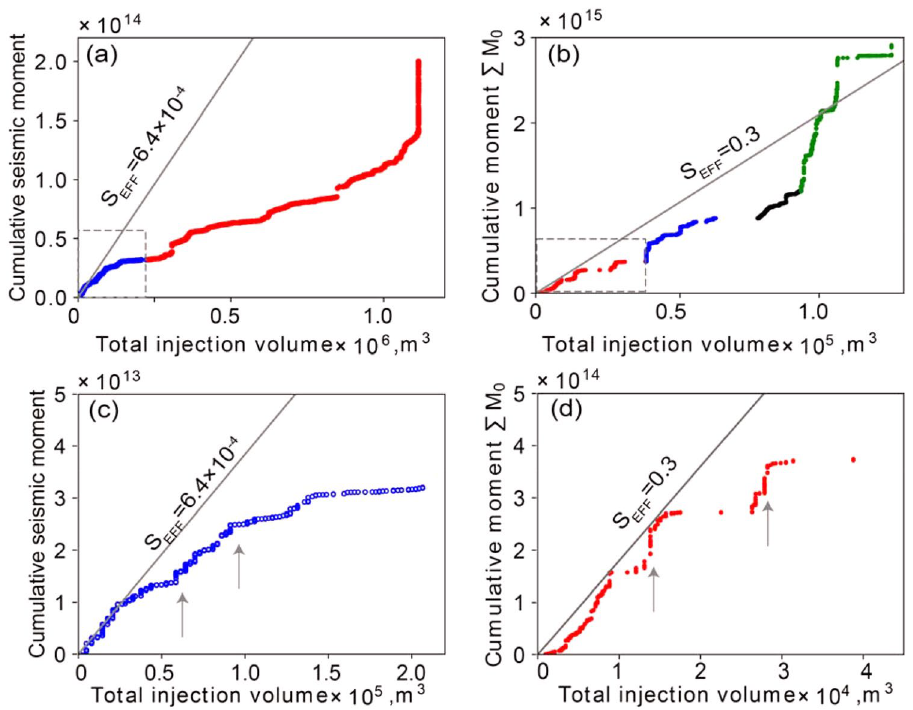
Figure 4. Cumulative seismic moment as a function of total injection volume. ( a ) and ( b ) show the cumulative seismic moment versus total injection volume in project areas 1 and 2, respectively. Slopes to evaluate S EFF (grey lines) are determined as the upper bound of the initial sampling data points in project one and project 2, zoomed in ( c ) and ( d ). Arrows indicate changes in slope for the relationship between cumulative seismic moment and total injected